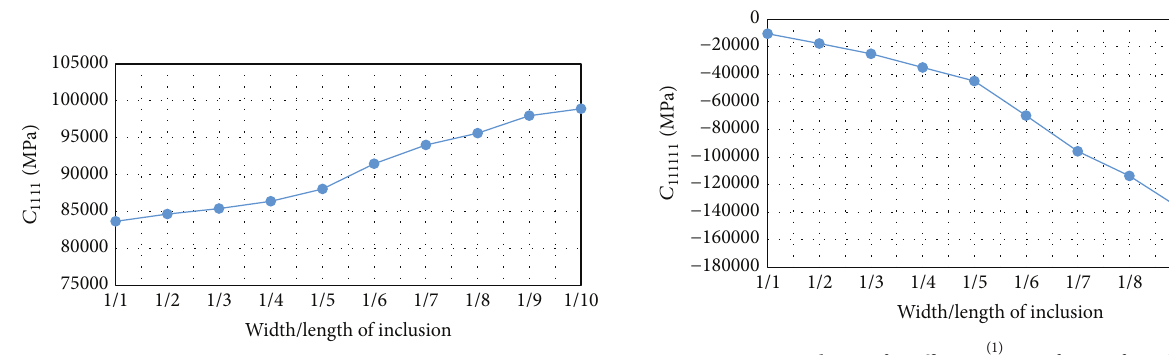
Figure 7: Dependence of coefficient versus concentration of reinforcing wires.